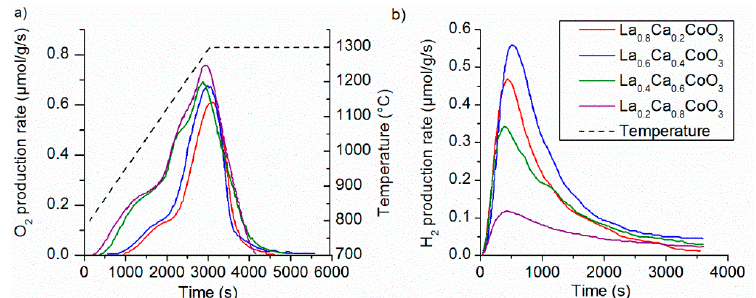
Figure 7. ( a ) O 2 production rate (T red = 1350 °C) and ( b ) H 2 production rate (T ox = 900 °C), for La 0.8 Ca 0.2 CoO 3 , La 0.6 Ca 0.4 CoO 3 , La 0.4 Ca 0.6 CoO 3 , and La 0.2 Ca 0.8 CoO 3